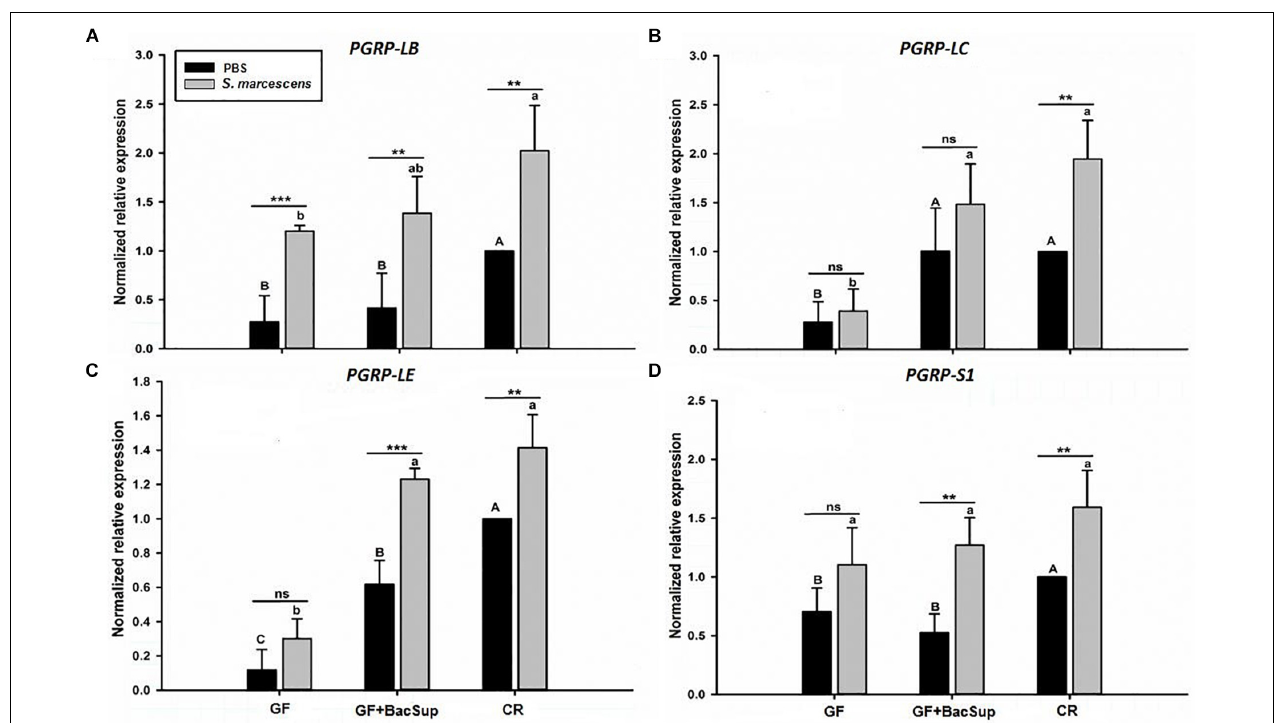
FIGURE 7 | The effect of bacterial challenge on the expression level of four peptidoglycan recognition protein genes in fat body of symbiotic (GF BacSup and CR) and aposymbiotic (GF) RPW larvae. The transcript of PGRP-LB (A) , PGRP-LC (B) , PGRP-LE (C) , and PGRP-S1 (D) are evaluated by RT-qPCR in fat body 6 h post-infection with Serratia marcescens or PBS as control. One-way ANOVA was conducted to evaluate the statistical differences across the groups using Tukey’s HSD post hoc multiple comparison. Uppercase letters indicate the statistical differences of control groups, whereas the lowercase letters represent bacterial infection across the different groups. “ ∗ ” presents the significance within each cohort ( t -test: ns, P > 0.05, P < 0.05, ∗∗ P < 0.01, ∗∗∗ P < 0.001). Error bars represent the standard deviation of four independent